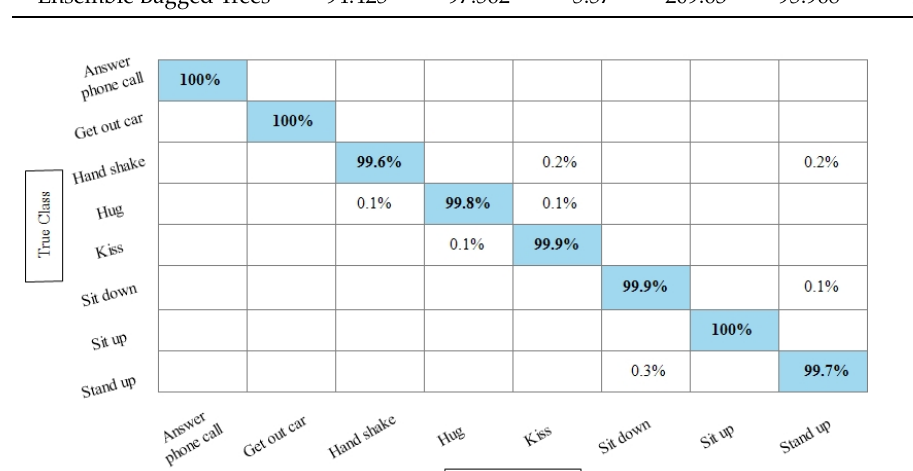
Figure 9. TPR based confusion matrix of Fine KNN using Hollywood dataset after fusion of deep features through SbE approach. Table 5. Achieved results on WVU dataset after fusion of deep features using SbE approach. The bold represents the best obtained values.